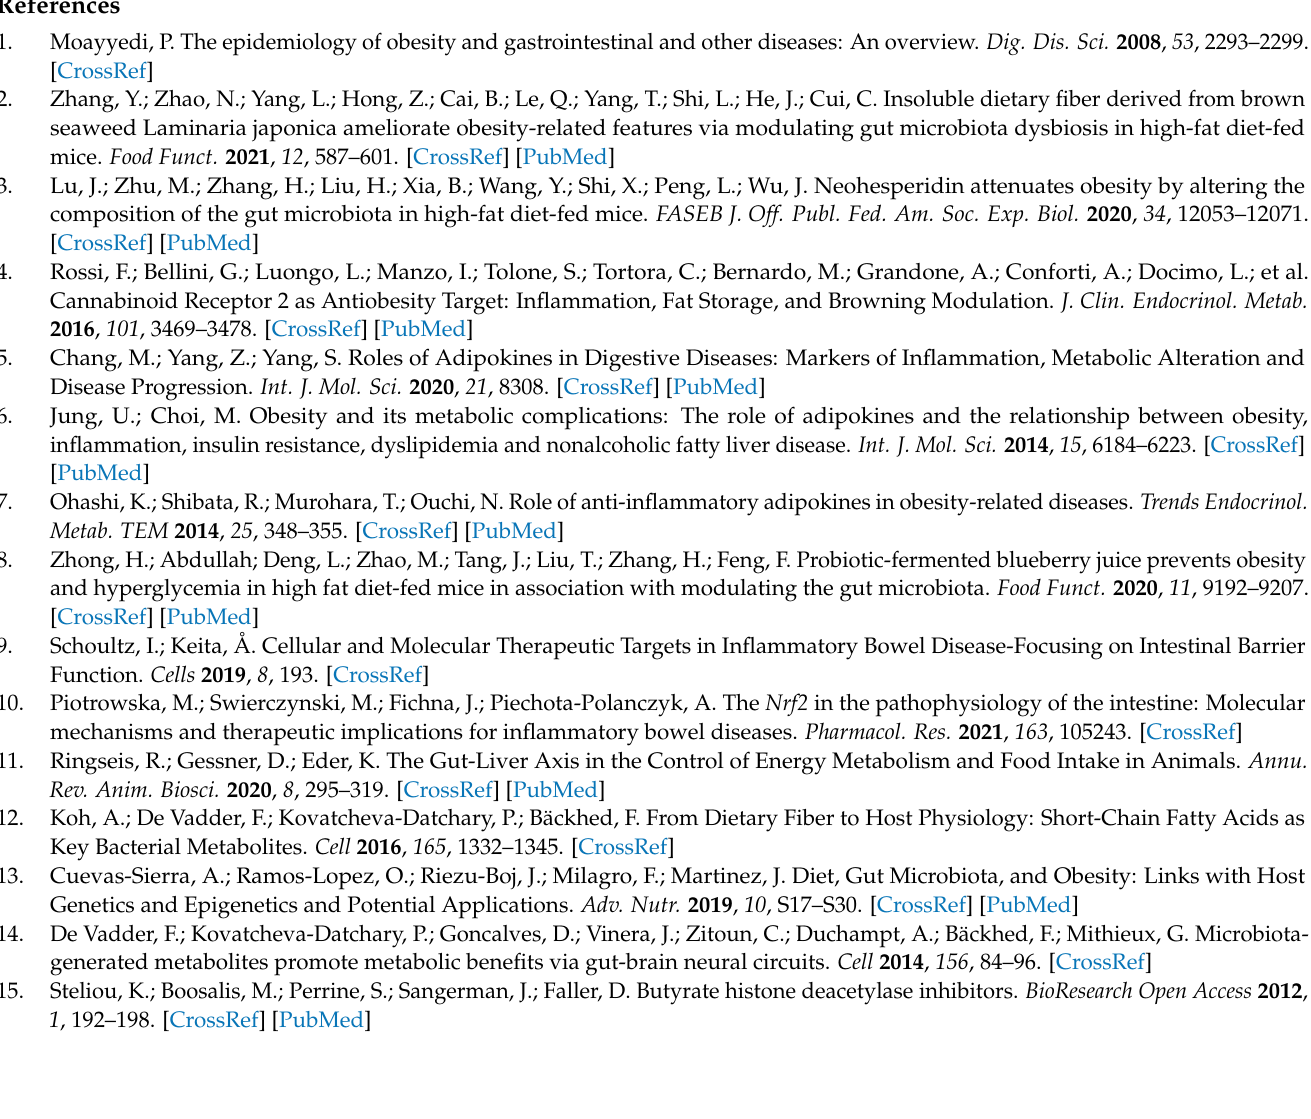
Table S1: Molecular weight standard